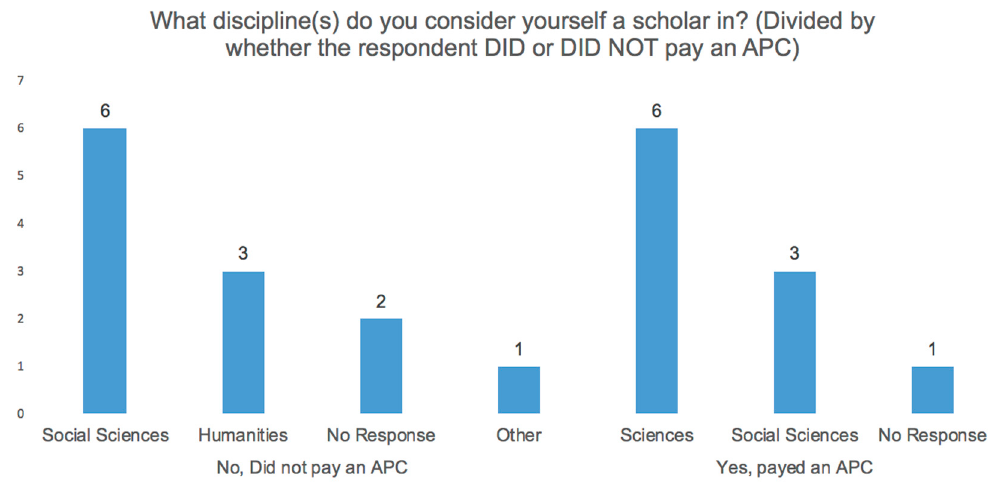
Figure 8. Prevalence of APC by Discipline.